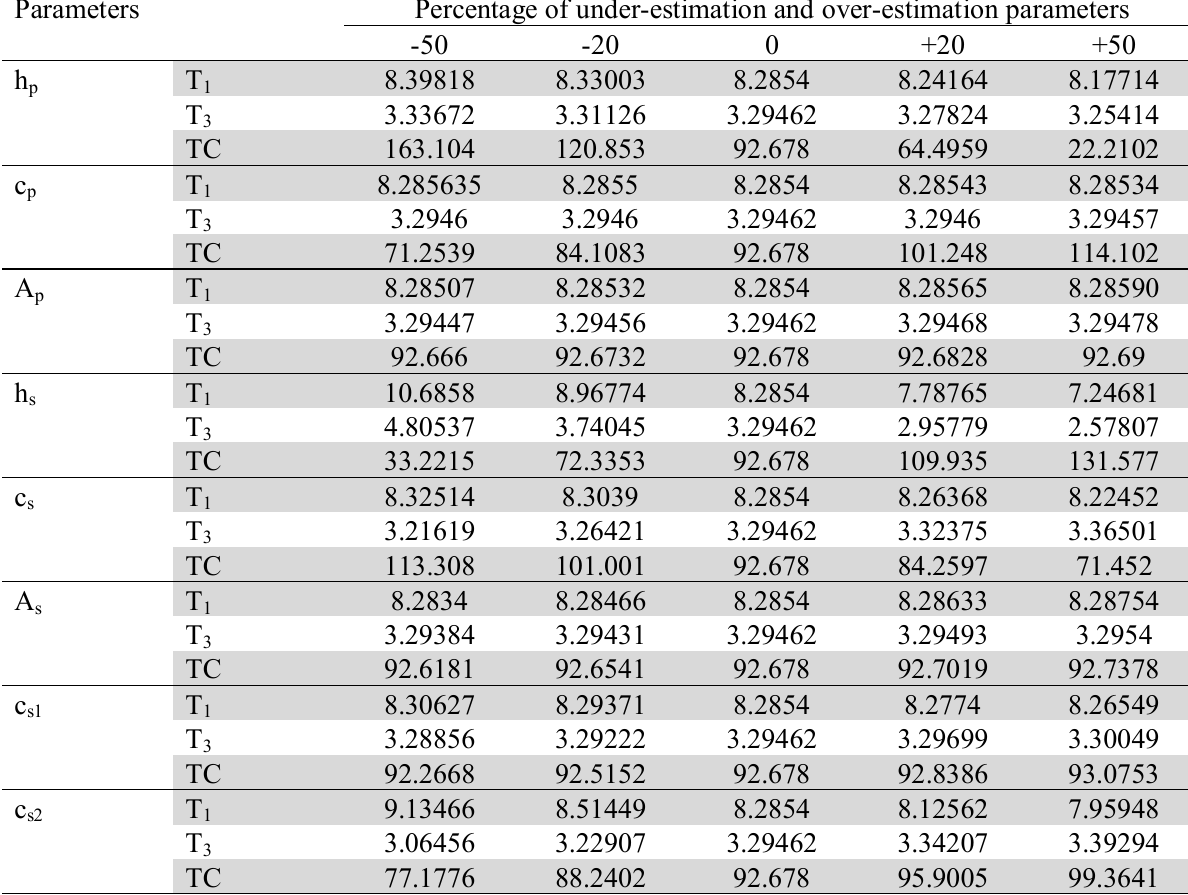
Sensitivty analysis of the proposed model